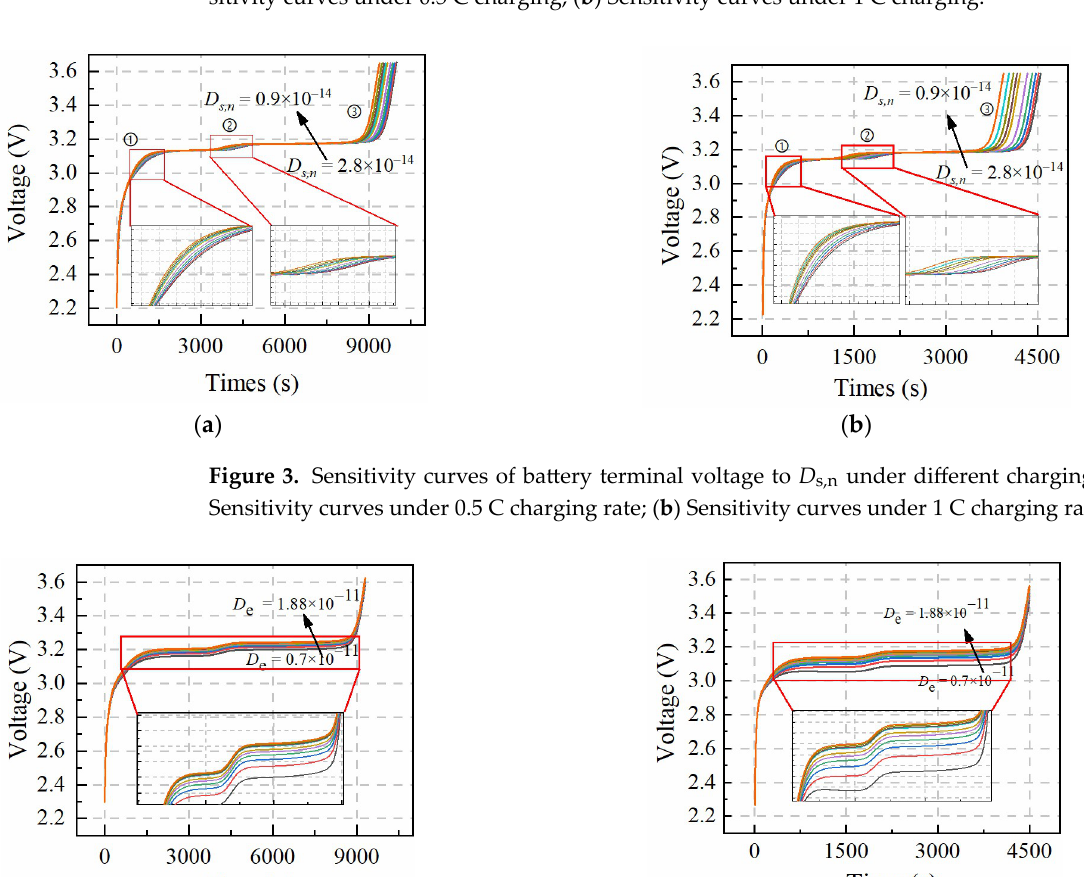
Figure 2. Sensitivity curves of battery terminal voltage to Q n under different charging rates. ( a ) Sen- sitivity curves under 0.5 C charging; ( b ) Sensitivity curves under 1 C charging.